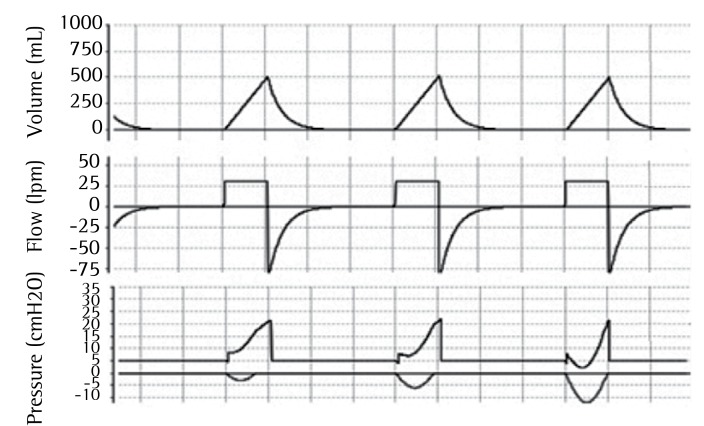
Flow asynchrony. In volume-controlled mode, the flow rate was adjusted
below the patient's demand; the patient thus maintained muscle effort
throughout inspiration, and the curve consequently became concave and
upward. The asynchrony exhibits increasing intensity from the first to the
third cycle, as represented in the figure. The negative deflections in the
pressure-time curve represent the patient's inspiratory effort (muscle
pressure) and are only visible when esophageal pressure is monitored.
Figures obtained at Xlung.net, a virtual mechanical ventilation simulator.
Available at: http//:www.xlung.net.